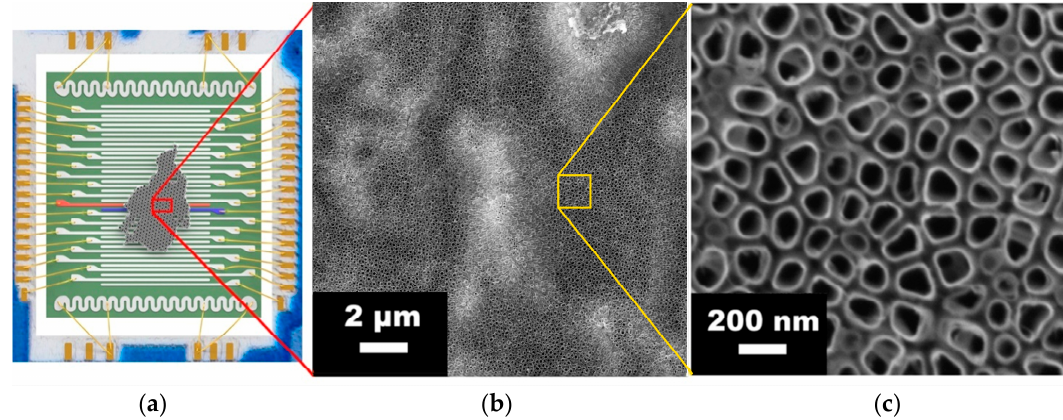
Figure 1. The multielectrode chip equipped with aTNTA layer: ( a ) cartoon of the studied chip with a piece of aTNTA membrane; red and blue electrodes indicate the layer segment under investigation; ( b , c ) the SEM images of the layer surface under different magnifications.